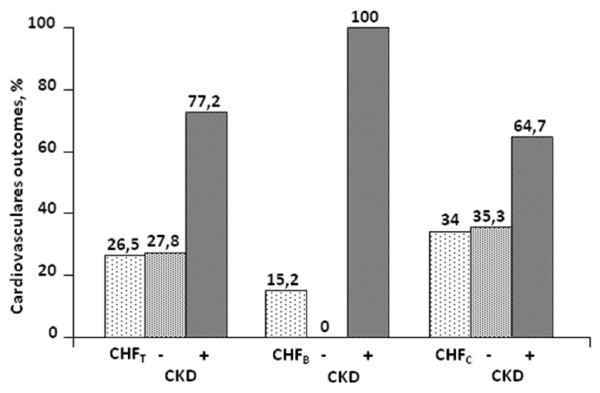
Presents the cardiovascular outcomes related to the presence or not of chronic kidney disease (CKD) in patients with the chronic heart failure as whole (CHFT), and after stratification by stages B (CHFB) and C (CHFC).